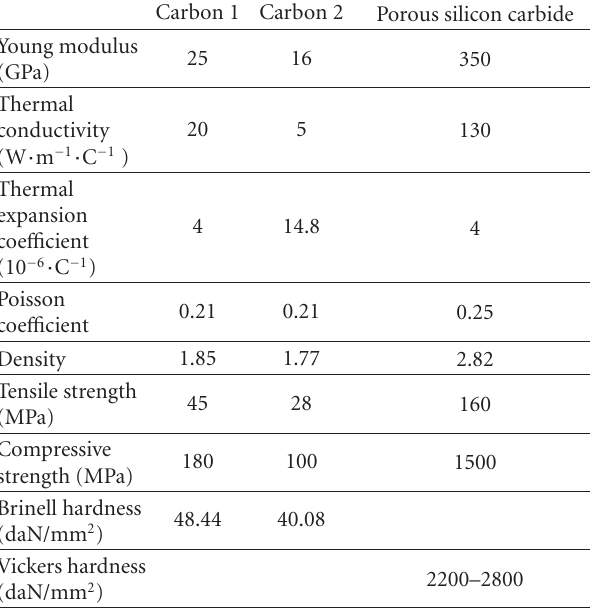
Table 1: Physical properties of the studied